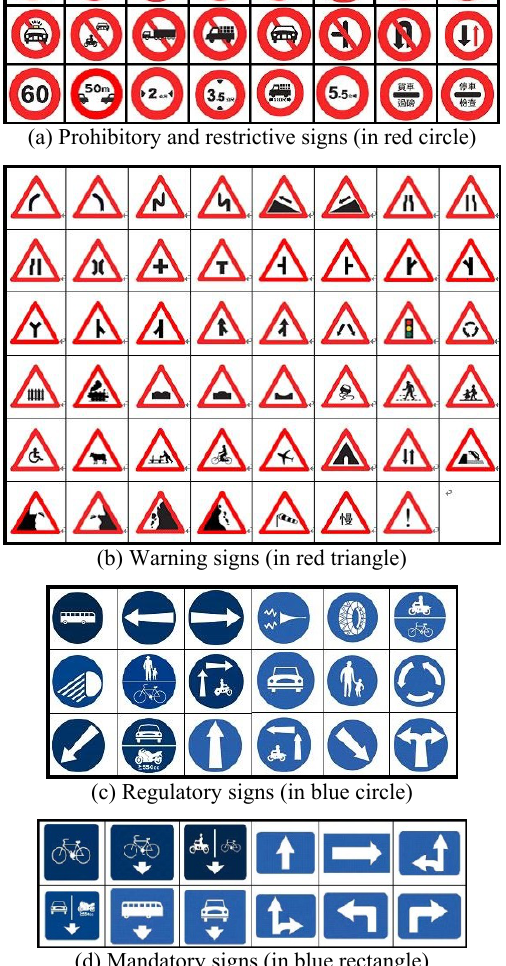
Figure 3. Standard traffic sign templates